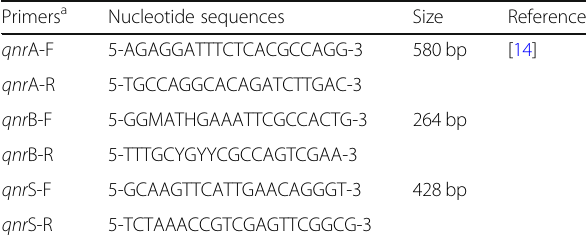
Table 1 Primers for polymerase chain reaction of qnr (A, B, and S)